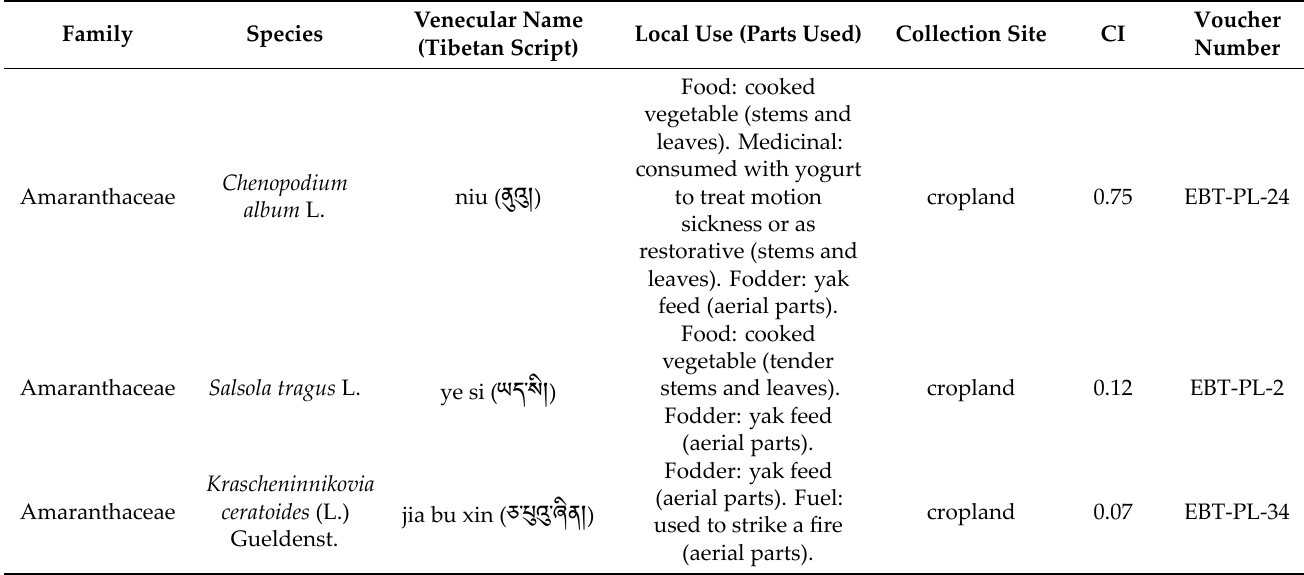
Table 2. Wild plants used by Tibetans in Burang